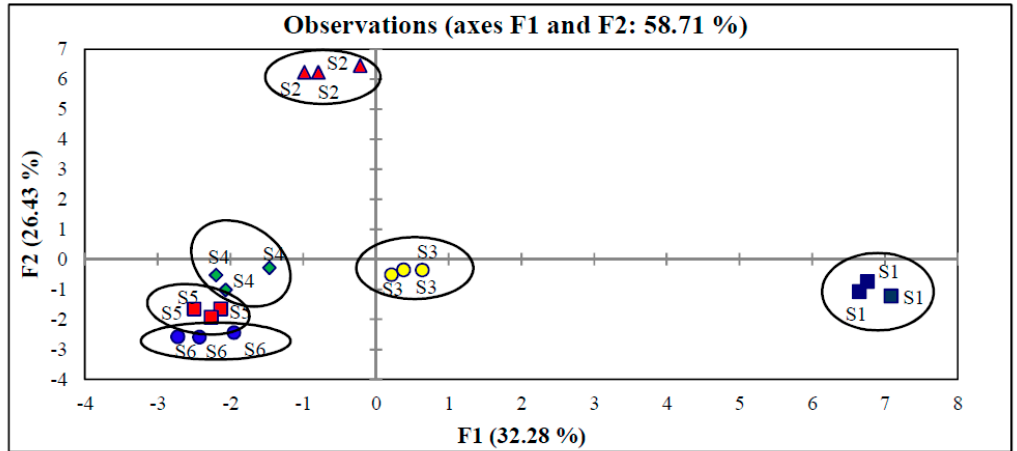
Figure 2. PCA plot on triplicate analysis of E. longifolia roots samples.